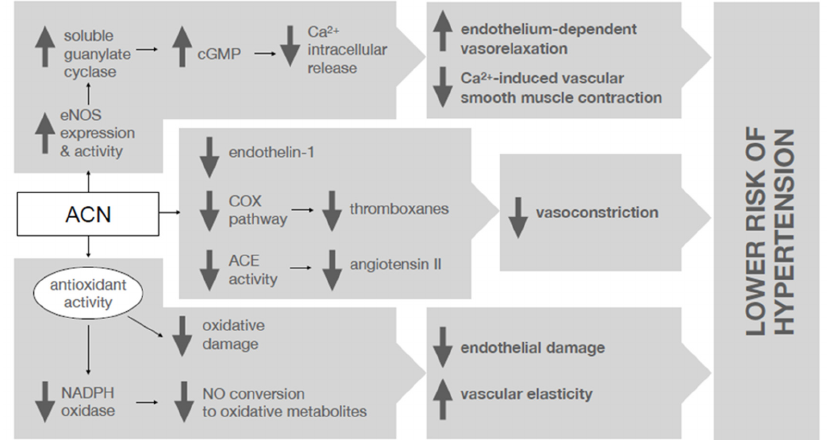
Figure 1. Potential mechanisms by which anthocyanins may improve vascular function and pre- vent endothelial damage. ACE, angiotensin converting enzyme; ACN, anthocyanins; cGMP, Cyclic guanosine monophosphate; COX, cyclooxygenase; eNOS, endothelial nitric oxide synthase; NADPH, nicotinamide adenine dinucleotide phosphate; NO, nitric oxide.